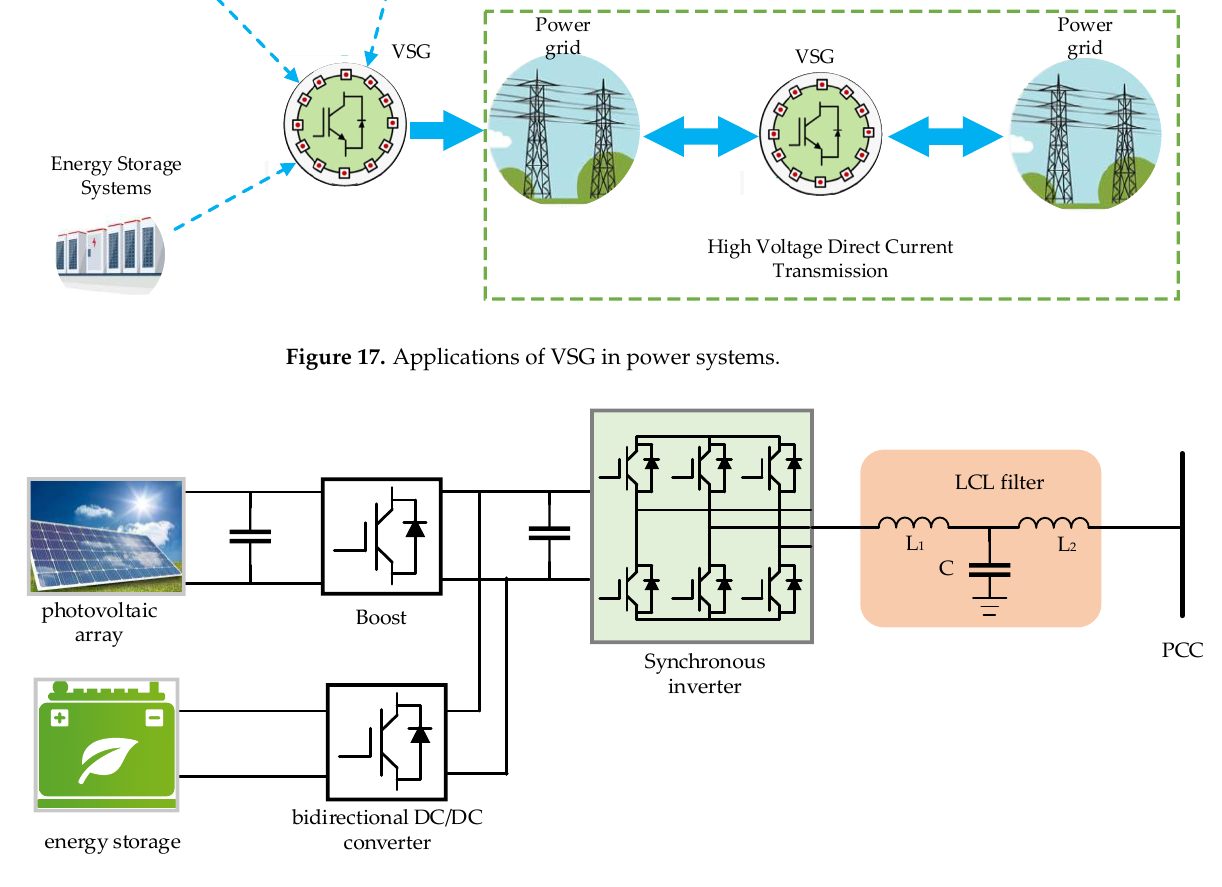
Figure 18. Schematic diagram of PVSG.